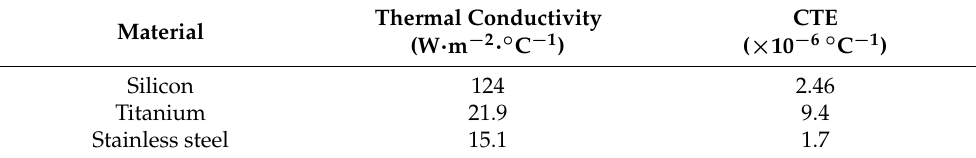
Table 7. Mechanical properties assigned in the model at room temperature. Material Elastic Moduli (GPa) Poisson’s Ratio Silicon E x = E y = 169 ν xy = 0.064 E z = 130 ν yz = 0.36 G xy = 50.9 G xz = 79.6 ν xz = 0.28 Titanium 96 0.36 Stainless steel 193 0.31 Table 8. Thermo-mechanical properties assigned in the model at room temperature. Thermal Material